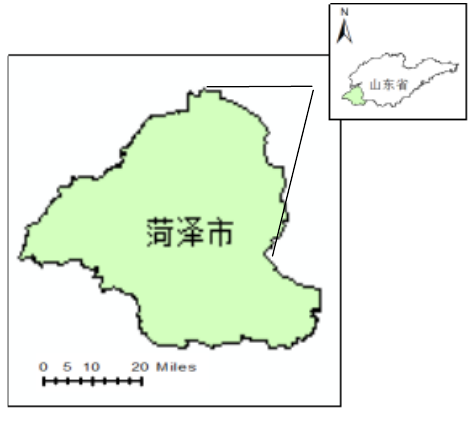
Figure 1. Location of the study